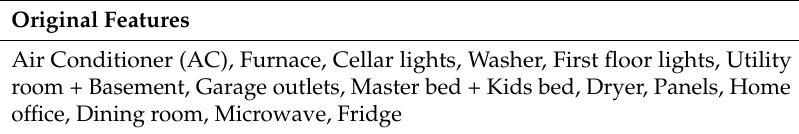
Table 5. Features in UMass Electric Dataset.